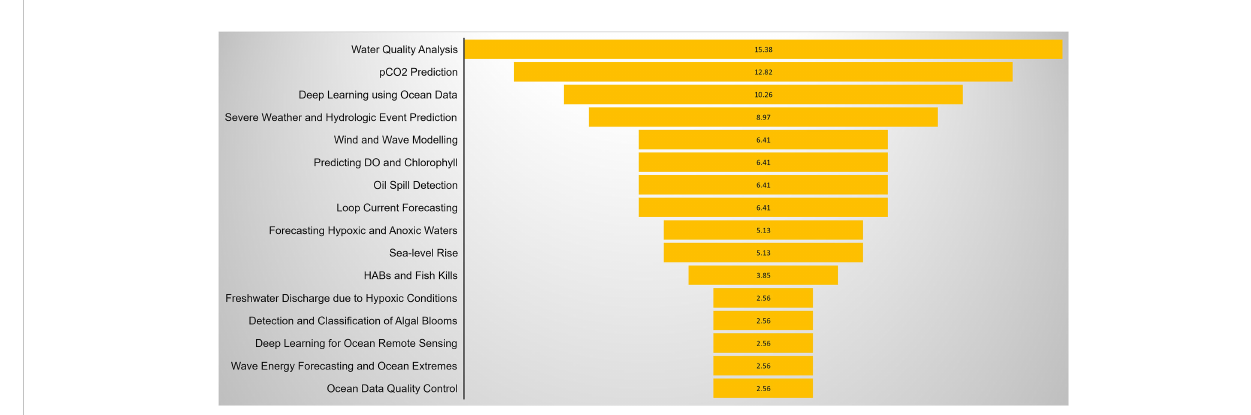
FIGURE 3 Illustration of the major areas of ML applications in the Gulf of Mexico, represented per the proportion of the literature covered under each area in this